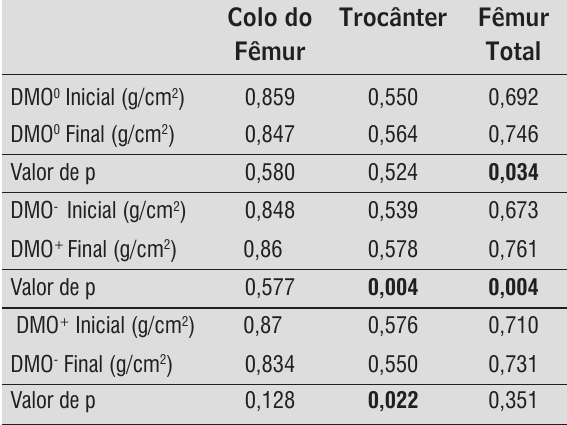
Tabela 3 - Médias dos valores de densidade